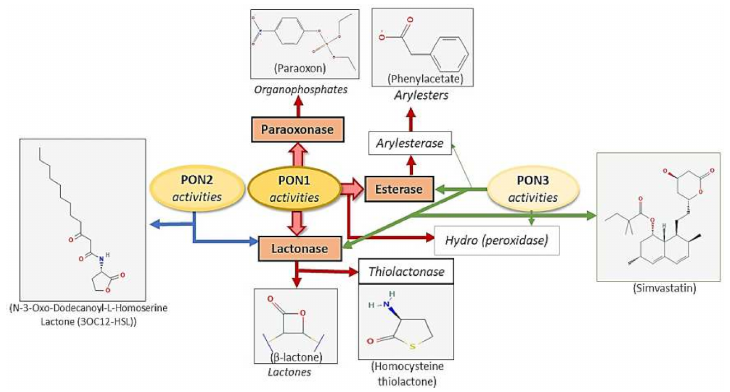
Figure 2. Paraoxonase family activities and